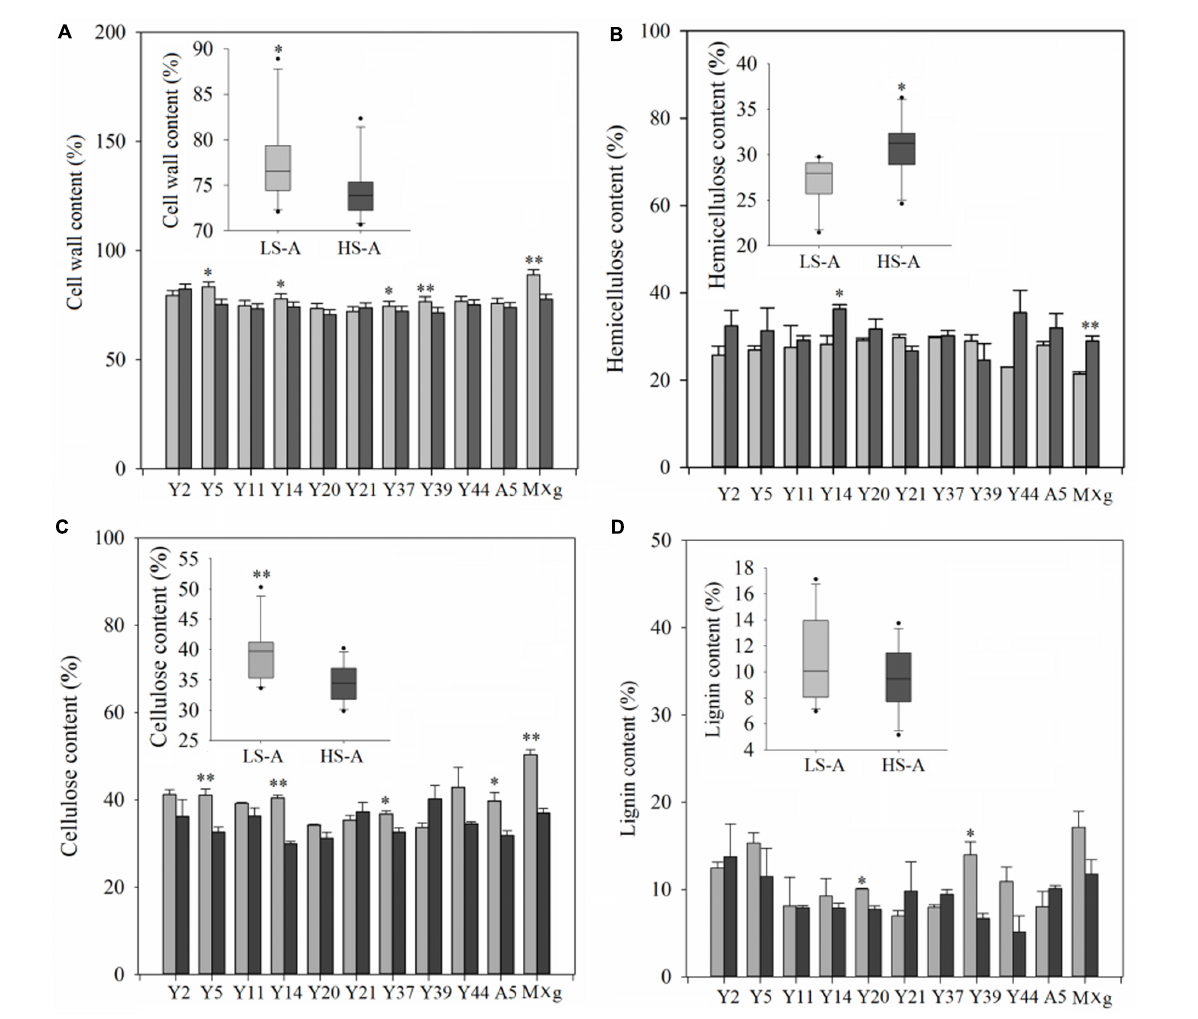
FIGURE4 (A) Lignocellulose content, (B) hemicellulose content, (C) cellulose content, and (D) lignin content of 11 genotypes of Miscanthus grown in low saline–alkaline soil (LS-A) (the light bars) and high saline–alkaline soil (HS-A) (the dark bars). Significance is denoted by ∗ P < 0.05 and ∗∗ P <